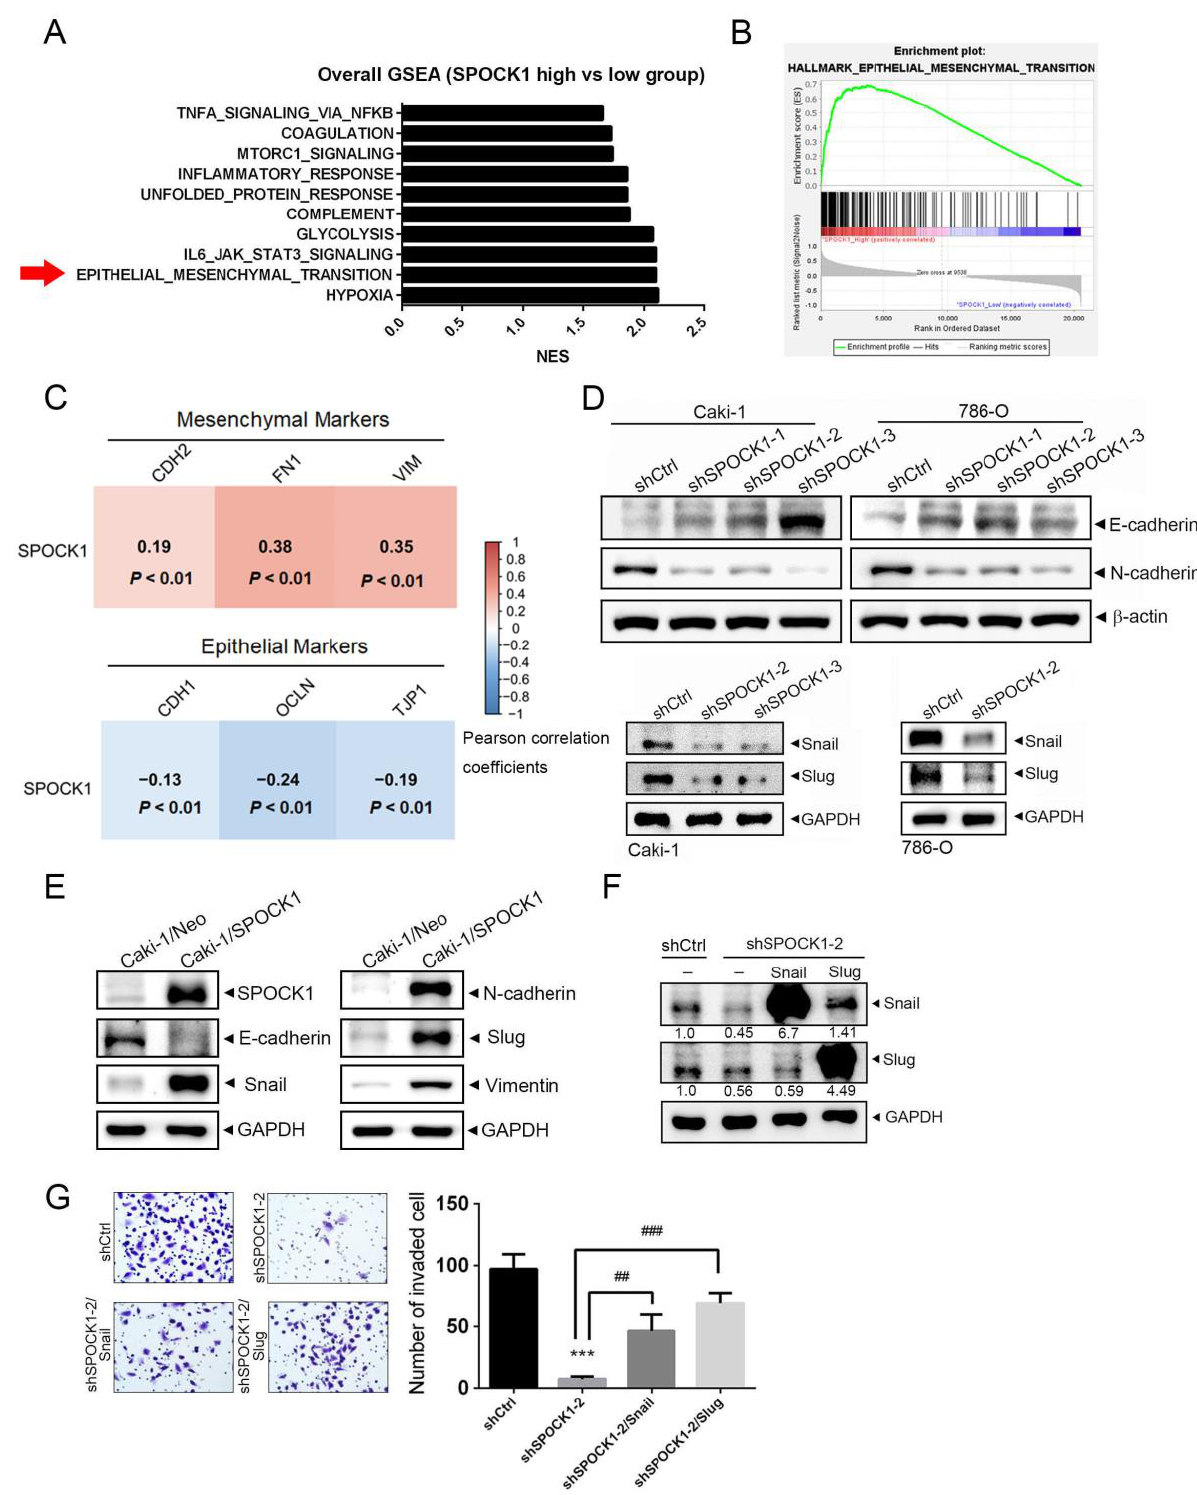
Figure 3. SPOCK1 promotes the epithelial-to-mesenchymal transition (EMT) in clear cell renal cell carcinoma (ccRCC) cells. ( A ) The gene set enrichment analysis (GSEA) was carried out using Hall- mark gene sets from the Molecular Signature Database (http://software.broadinsti- tute.org/gsea/msigdb/index.jsp, accessed on 28 August 2022). Statistically significant signatures were selected (with a false detection rate (FDR) of <0.05) and placed in order of the normalized enrichment score (NES), which represents the strength of the relationship between the phenotype and gene signature. Black bars indicate pathways enriched in the high − SPOCK1 − expression group. ( B ) GSEA of TCGA KIRC dataset showed an enrichment of gene signatures associated with the EMT in the high − SPOCK1 − expression group. ( C ) The correlations between the gene expression of SPOCK1 and EMT markers are demonstrated in the correlation plot. The RNA sequencing data of TCGA KIRC patients were utilized to perform this analysis. Pearson correlation was conducted to evaluate the relation between SPOCK1 and EMT markers. The correlation coefficients and p values